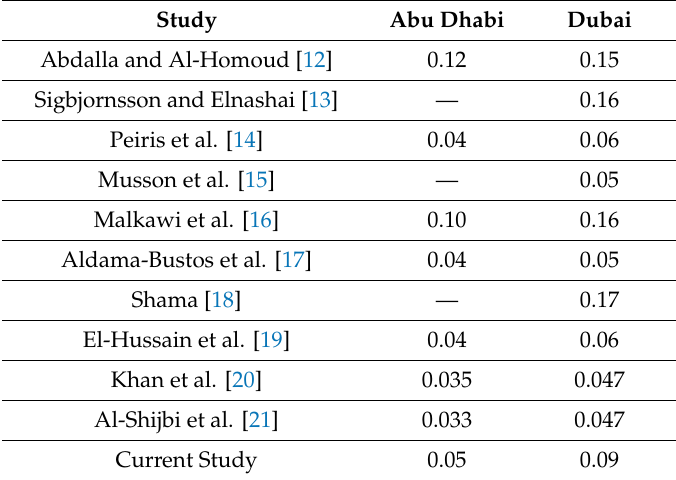
Table 2. Previously estimated PGA (g) values, for rock-site conditions and a return period of 475 years, for the quoted seismic hazard assessments, which arranged chronologically, for the emirates of Abu Dhabi and Dubai, in comparison with the obtained values in the current study.